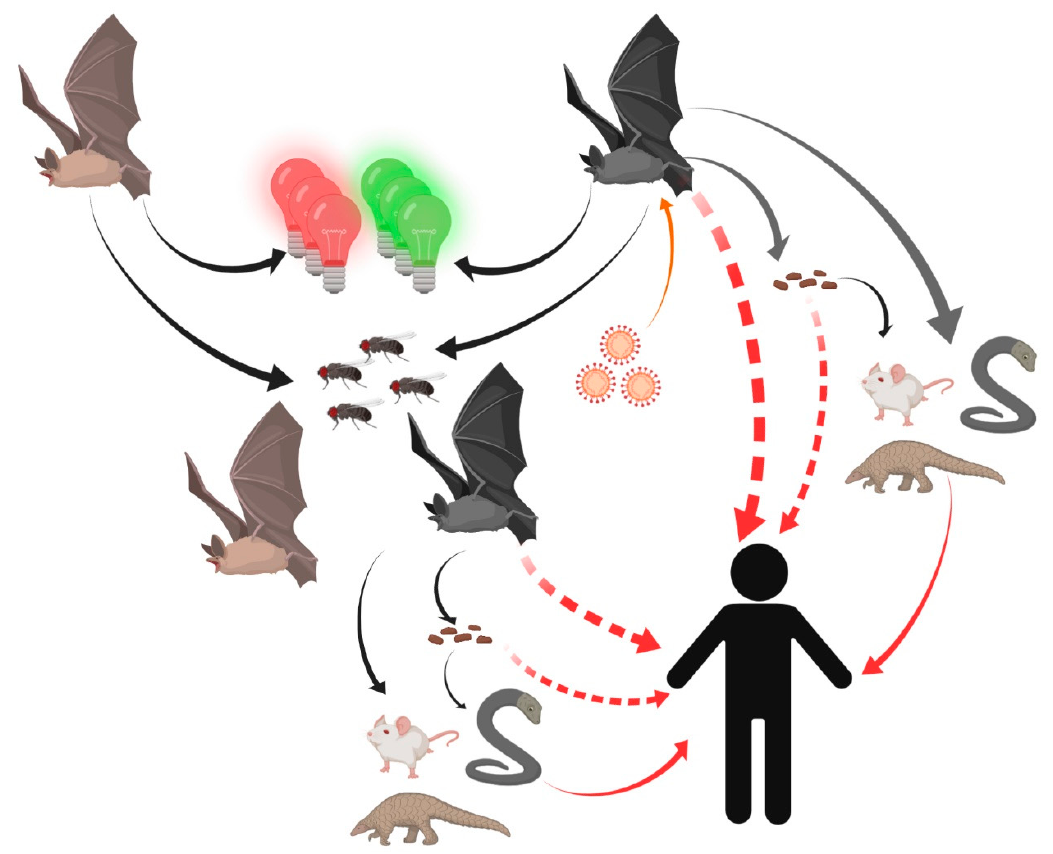
Figure 2. Potential transmission routes for SARS-CoV-2 to humans. Bats carrying SARS-CoV-2 were attracted by green or red lights and settled into insect-rich areas. SARS-CoV-2 transmitted to humans directly or spread to intermediate hosts such as bamboo rats, snakes, and pangolins through bats’ saliva, urine, and feces. Intermediate hosts transmitted SARS-CoV-2 to humans.